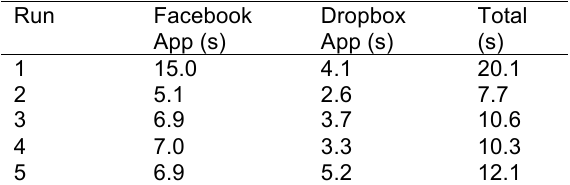
Table 2. The time in seconds over 5 runs to upload a 112KB image to Facebook and Android using the individual native